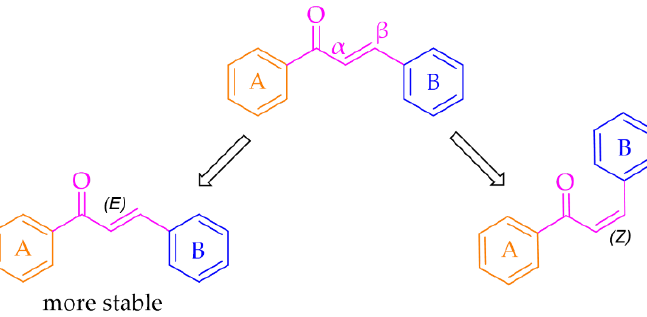
Figure 3. General structure of chalcones and possible isomers.